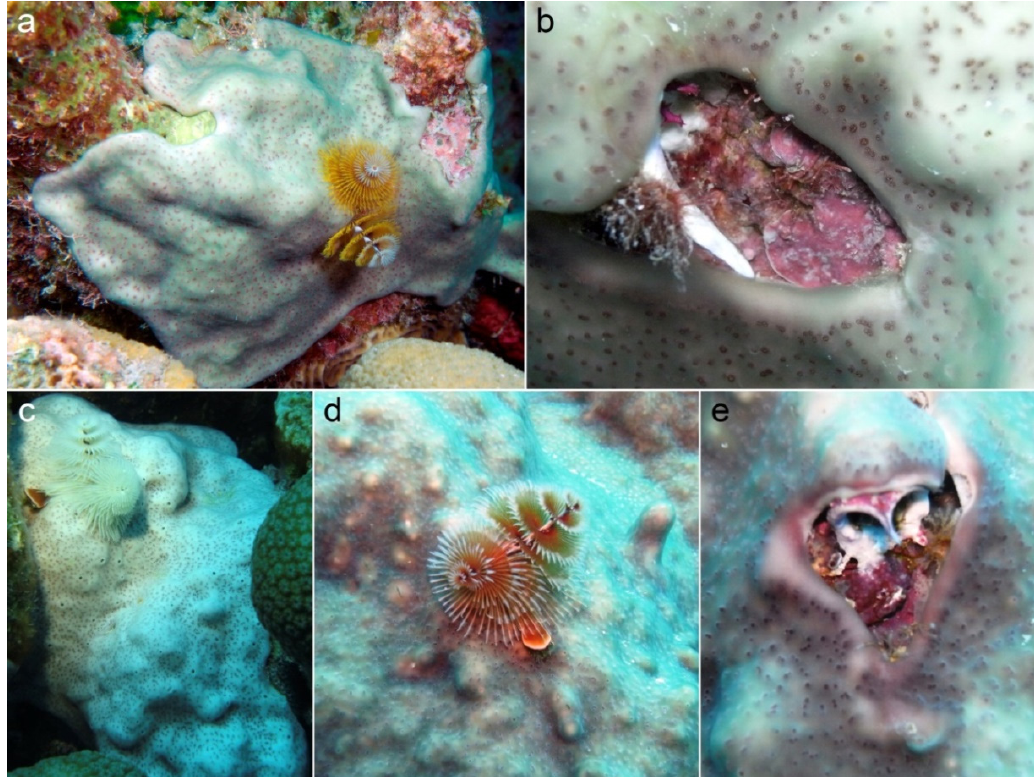
Figure 4. Trididemnum solidum acting as a secondary host for Spirobranchus giganteus in the Southern Caribbean: ( a,b ) dive site “Thousand Steps” (12°12'39" N 68°19'17" W), Bonaire (2019); ( c ) Marie